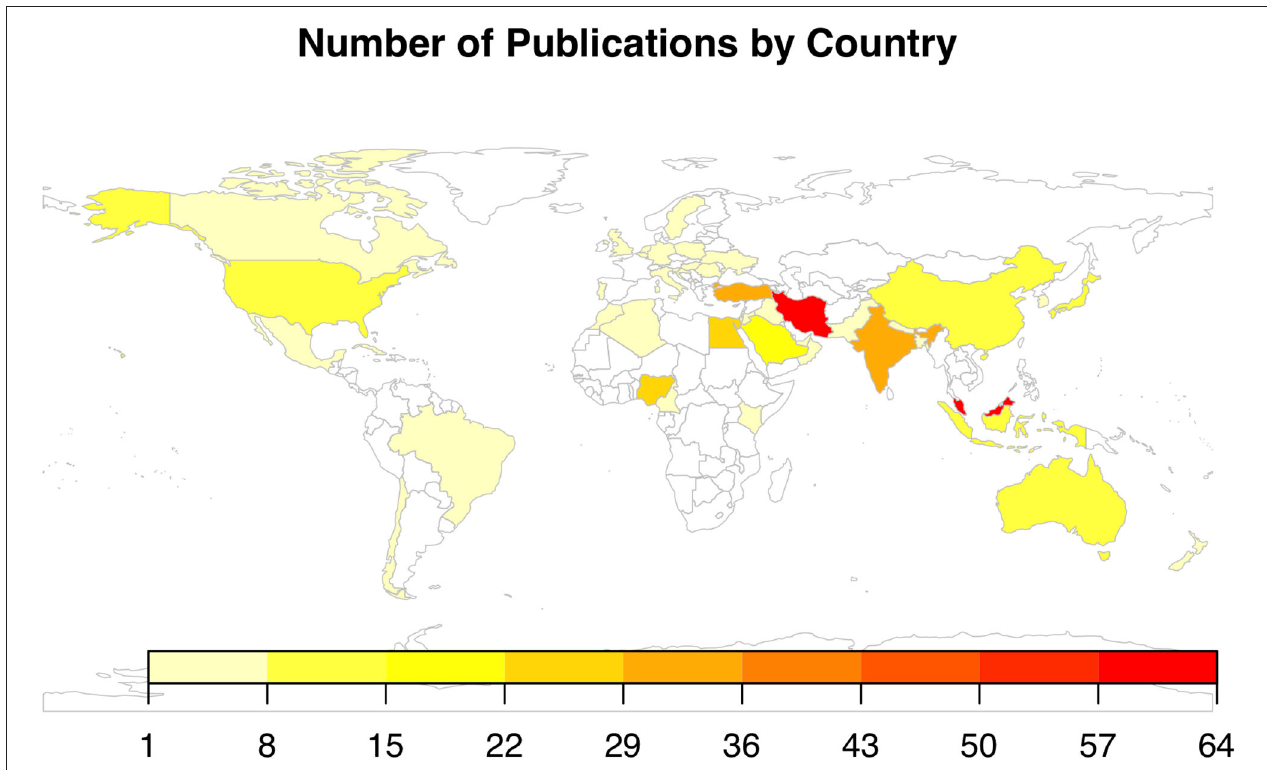
FIGURE 2 | Chloropleth map of the number of publications by country for articles included in a scoping review of the evidence for the medicinal use of honey in animals ( n = 397), with 45 countries represented. Iran and Malaysia contributed the greatest number of publications.